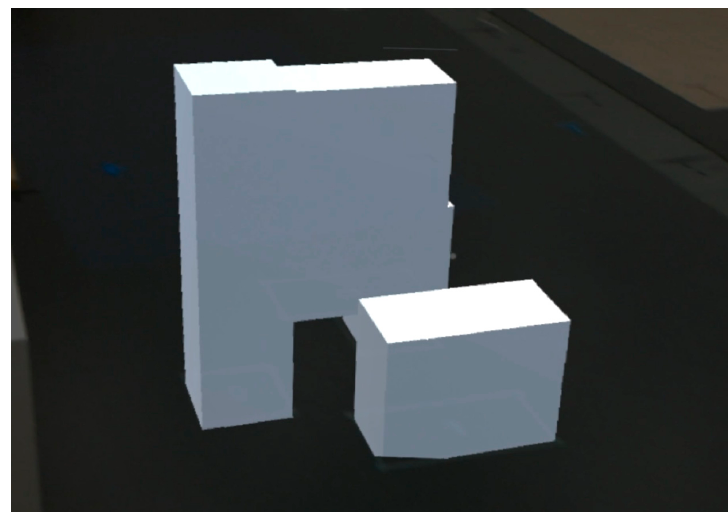
Figure 8. A simple scene of opaque rectangular prisms as viewed from the HMD, showing the “standard” rendering used in HMDs. HMD FOV clipping is visible on the bottom of the front prism.